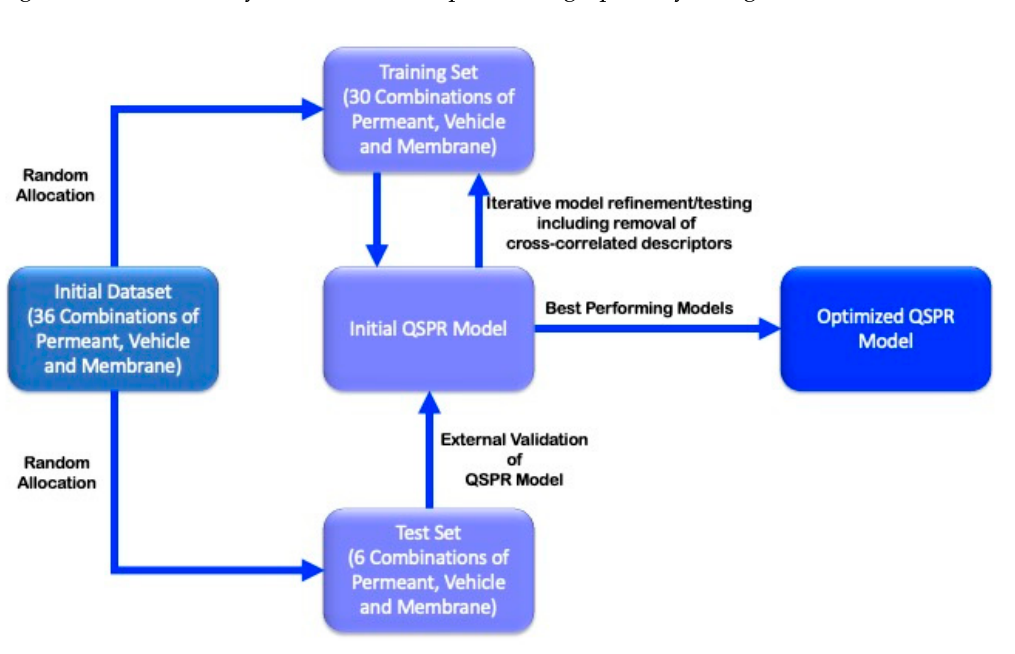
Figure 1. Graphical overview of the quantitative structure–permeability relationship (QSPR) modelling process.